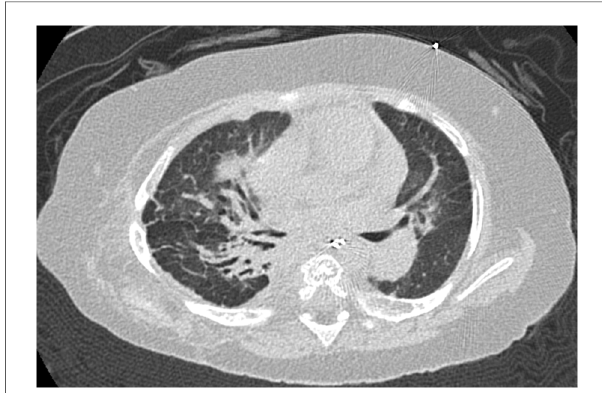
FIGURE 3 Case 2: axial CT images of lung window settings at 1 year of age. Axial CT images show parahilar consolidation and subpleural linear opacities of atelectasis or fi brosis with bronchodilation, predominantly in the right lung fi eld.